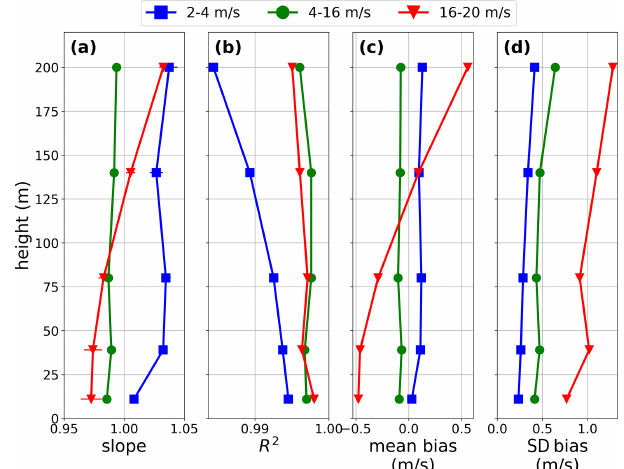
Figure 8. Profiles of linear regression analysis results and biases in the wind speed, applied to three different wind speed classes: 2– 4ms − 1 (blue squares), 4–16ms − 1 (green circles) and 16–20ms − 1 (red triangles). Panels (a, b) show the parameters from a linear re- gression (slope and R 2 ), and panels (c, d) show the mean bias and standard deviation of the bias. The error bars in panel (a) indicate the standard uncertainties of the parameter estimates (often behind the